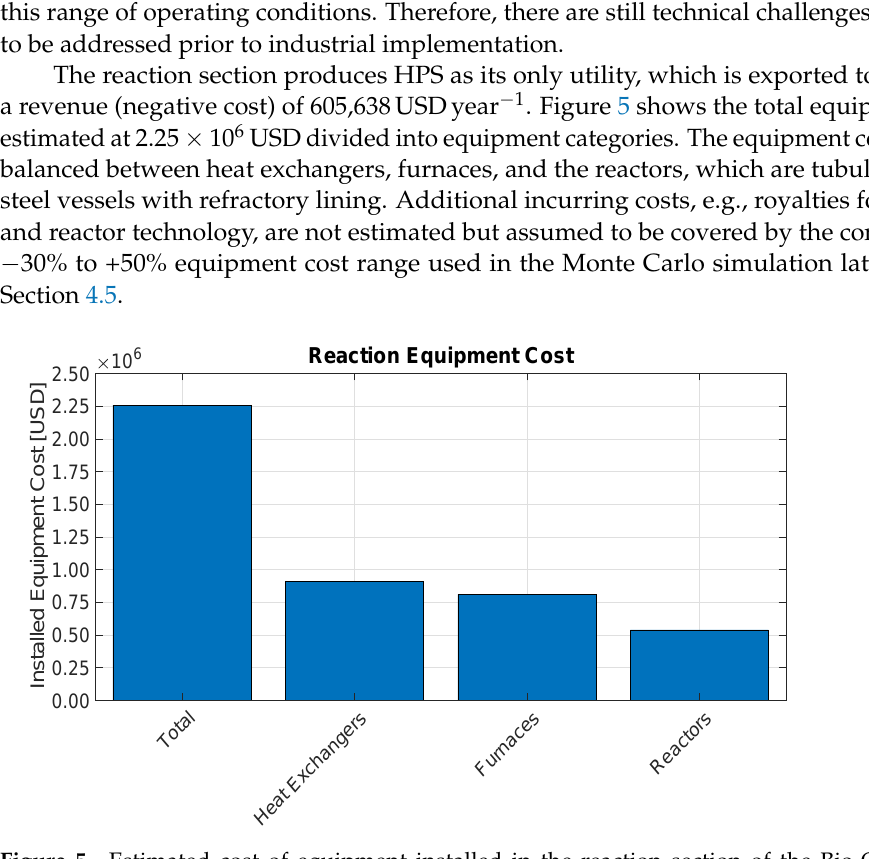
Figure 5. Estimated cost of equipment installed in the reaction section of the Bio-OCM plant. Reproduced with permission from Penteado, Ph.D. Thesis, TUB, 2021